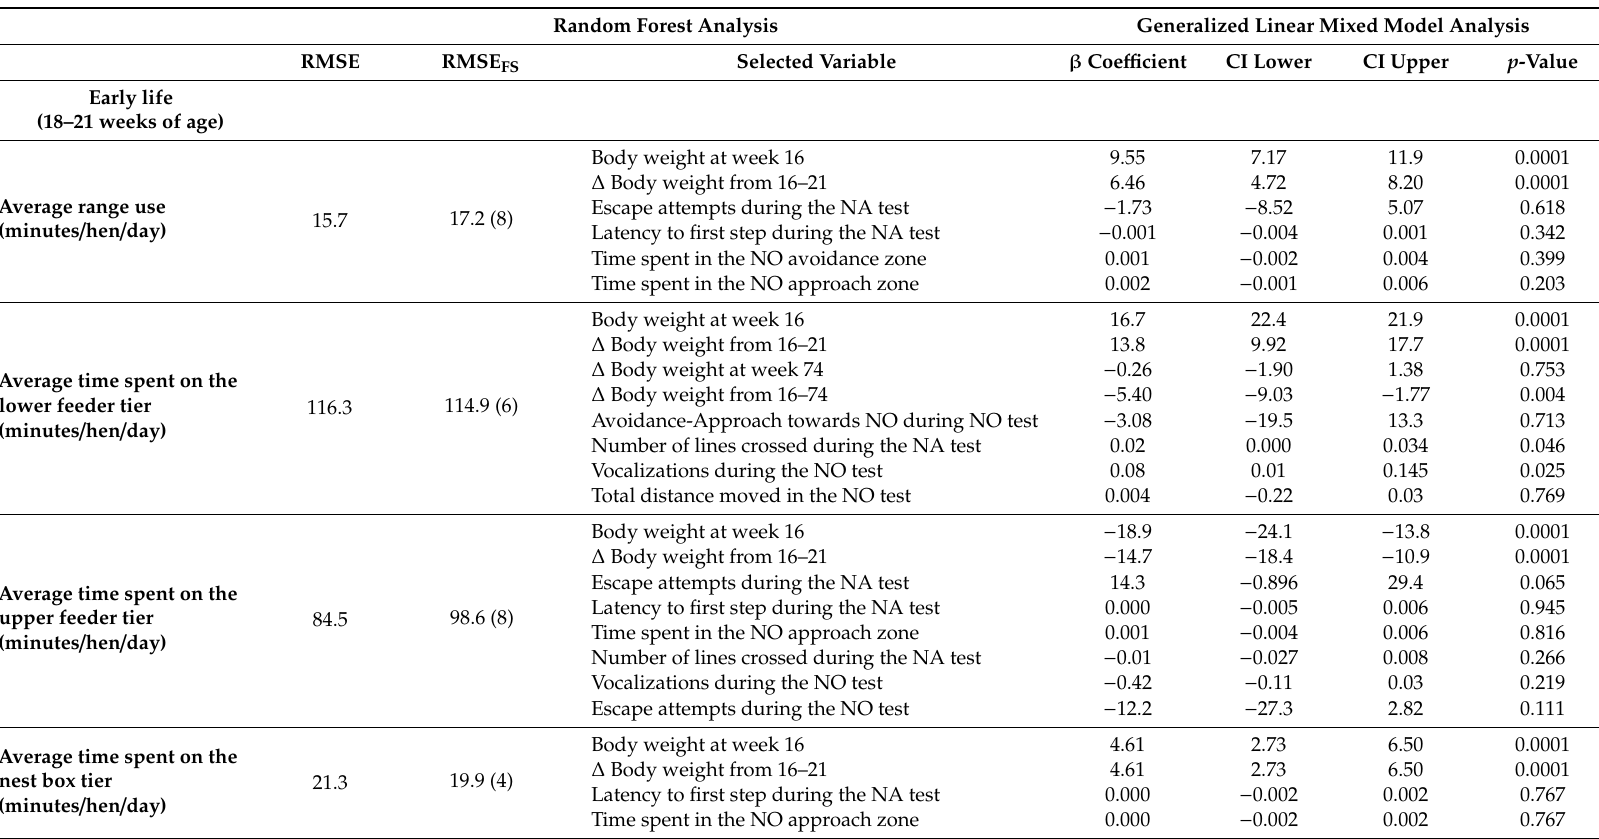
Table 4. The root mean square error (RMSE) values (number of selected features in parentheses) obtained based on the confusion matrix to assess the model performance and to determine the number of features (behavior and body weights parameters) to be included in further analysis obtained from Random Forest Analysis. Generalized Linear Mixed Model Analysis determined the relationship between the predictor (time spent on the range, lower feeder tier, upper feeder tier, or nest box tier) and response variables to determine the relationship between use of space in an aviary housing system and behavioral indicators of fearfulness and exploration. β coe ffi cient values indicate the direction and strength of the relationships and significant relationships are indicated by p -values of <